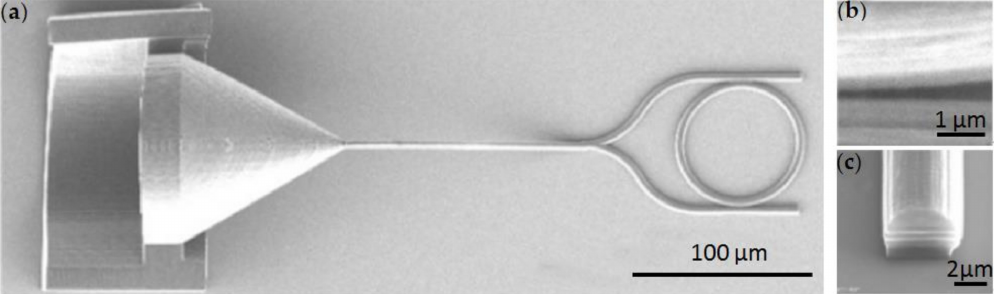
Figure 4. ( a – c ) SEM image of resonant micro-ring by DLW